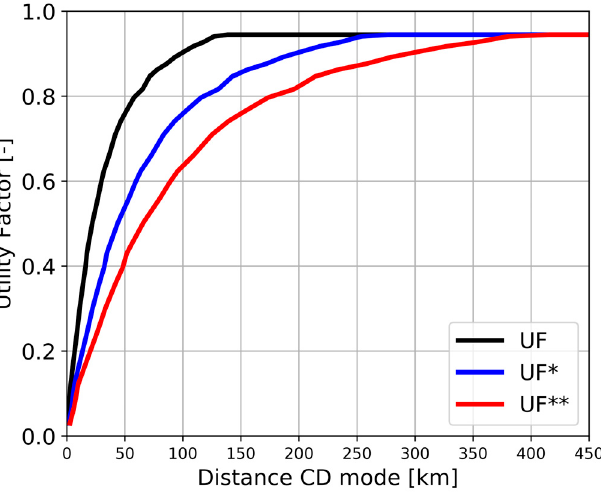
Figure 8. Representation of the utility factor used in this study. UF is the PHEV light-duty vehicle defined by SAE J2841, UF* is the scale version multiplied by two, and UF** the scale version multiplied by three.